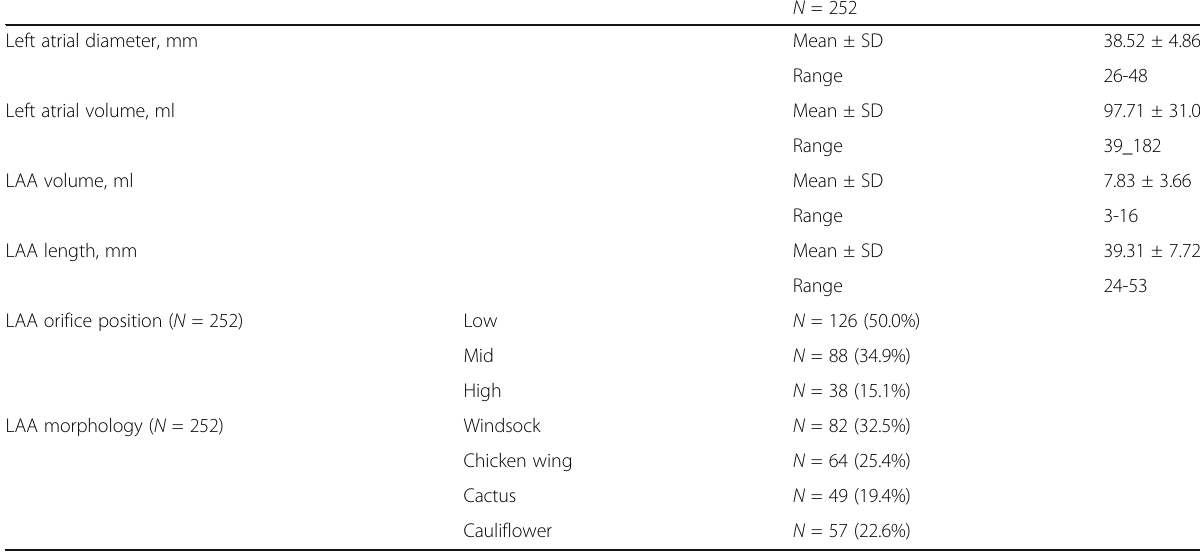
LAA left atrial appendage, SD standard